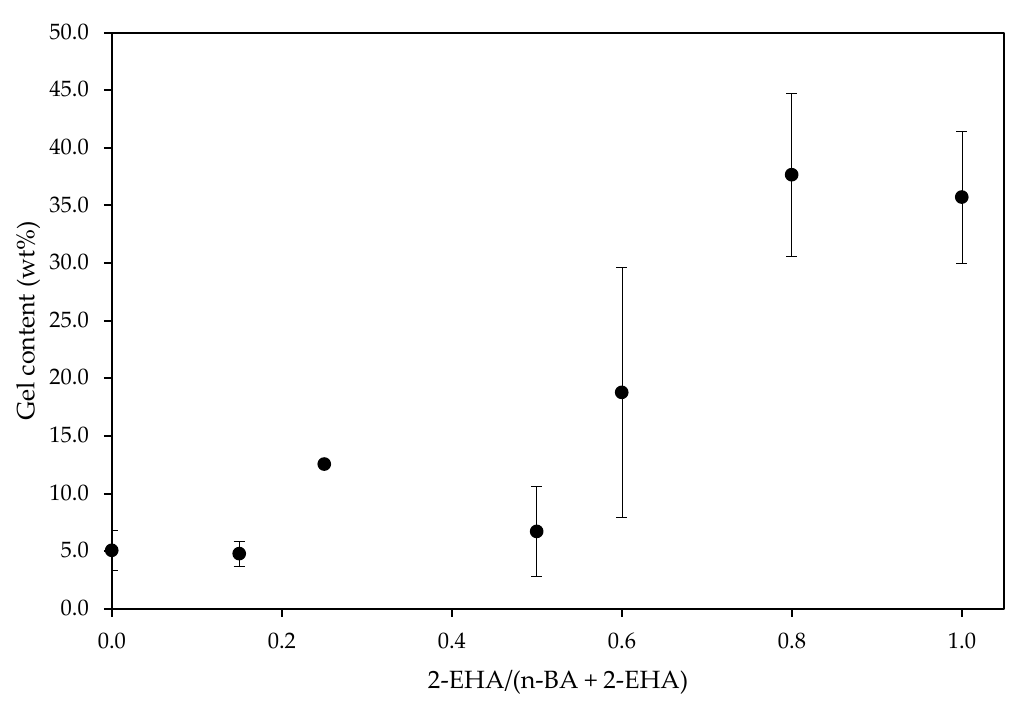
Figure 2. Variation of the gel content with the co-monomer ratio.